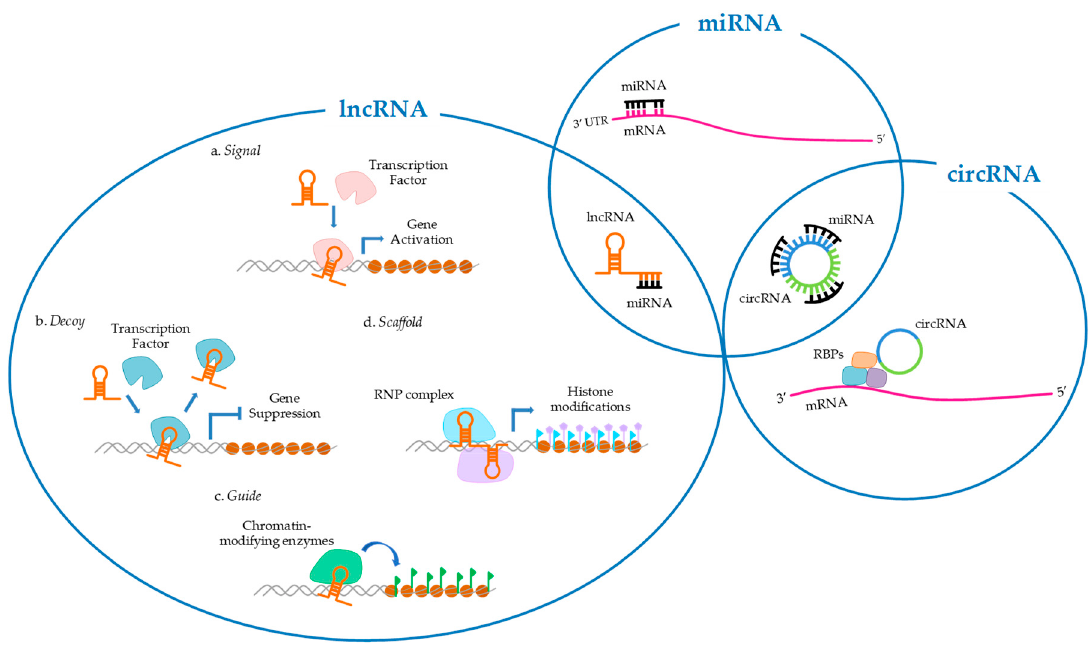
Figure 1. Overview of the interactions and functions of ncRNAs in CSCC. ncRNAs are involved in several fundamental cellular processes, such as cell proliferation, apoptosis, migration, invasiveness, and angiogenesis through chromatin remodelling, transcription, post-transcriptional modifications, and signal transduction. Specific activities of ncRNAs are limited in separated circles, while common involvements are reported in the overlapping circles. miRNAs can target mRNAs on the 3 ′ UTR site by inhibiting gene expression or circRNAs and lncRNAs by regulating their stability. In turn, circRNAs can directly regulate the gene transcription of mRNAs by binding and sequestering RNA-binding proteins (RBP) with the formation of the RNA-protein complex (RPC). In addition, both circRNAs (CDR1as, circ_0070934 [42]) and lncRNAs (HOTAIR [43],LINC00319 [46], LINC00963 [47]) can sequester miRNAs by acting as “miRNA sponges” in order to regulate their availability. lncRNAs are classified into four categories according to their functions: (a) as signals, helping genes transcription; (b) as decoys, binding and removing transcription factors from chromatin in order to suppress gene expression; (c) as guides, acting, either in cis or trans, on target genes and promoting their activation or repression through the recruitment of chromatin-modifying enzymes; (d) as scaffolds, forming a ribonucleoprotein (RNP) complex that affects histones modifications (MALAT [38]).